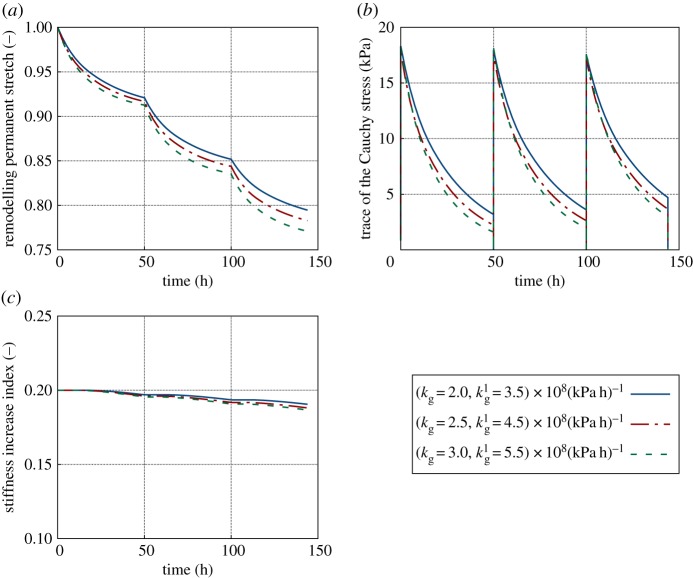
Remodelling permanent stretch, ϑ (a), trace of the Cauchy stress, tr σ (b) and stiffness increase index, Deff (c), at a representative Gauss point of the inner cavity wall. Evolution through three foam changes (at 0, 50 and 100 h) considering the combined values kg and k1g in the mechanical growth function ϕ(σe) of 2.0×108 and 3.5×108, 2.5×108 and 4.5×108, or 5.5×108 and 3.0×108 (kPa h)−1.